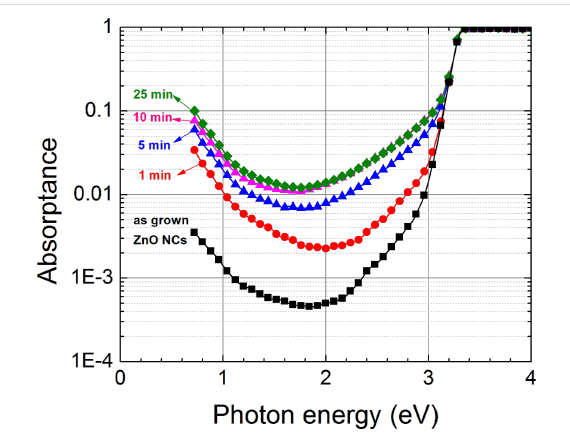
Figure 4: The optical absorptance spectra of as-grown ZnO nanocol- umns and NCs treated in O-plasma for 1, 5, 10 and 25 min.